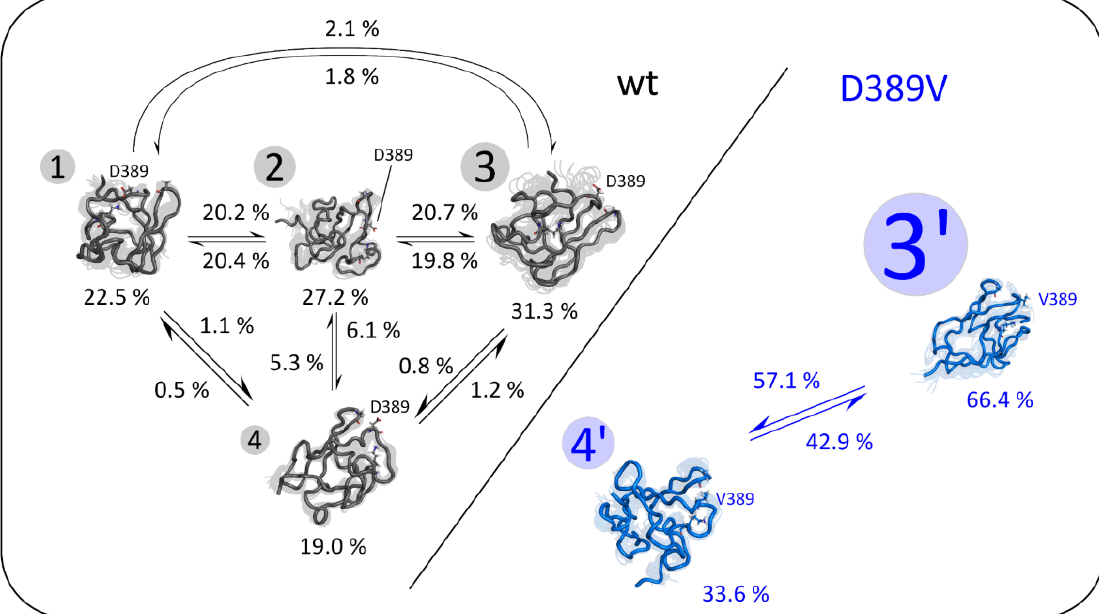
Figure 3. Kinetic network representation derived from the clustered major conformations of C2 wt and D389V. Representative conformations of the States (1) to (4) identified in Figure 2 are shown for C2 wt (black), and (3′) and (4′) are shown for D389V (blue). Backbone Cα is shown as a tube representation, and the side chains of residues D389, V389, K395, and A417 are shown as ball–and–stick models with CPK coloring. The opaque underlay displays 40 conformers of each state. The numbers with circular background denote different states. Their size corresponds to the relative occupancy of each state over the course of the simulation, which is shown below the respective conformers. Arrows and percentages reflect probabilities of transition between two states.